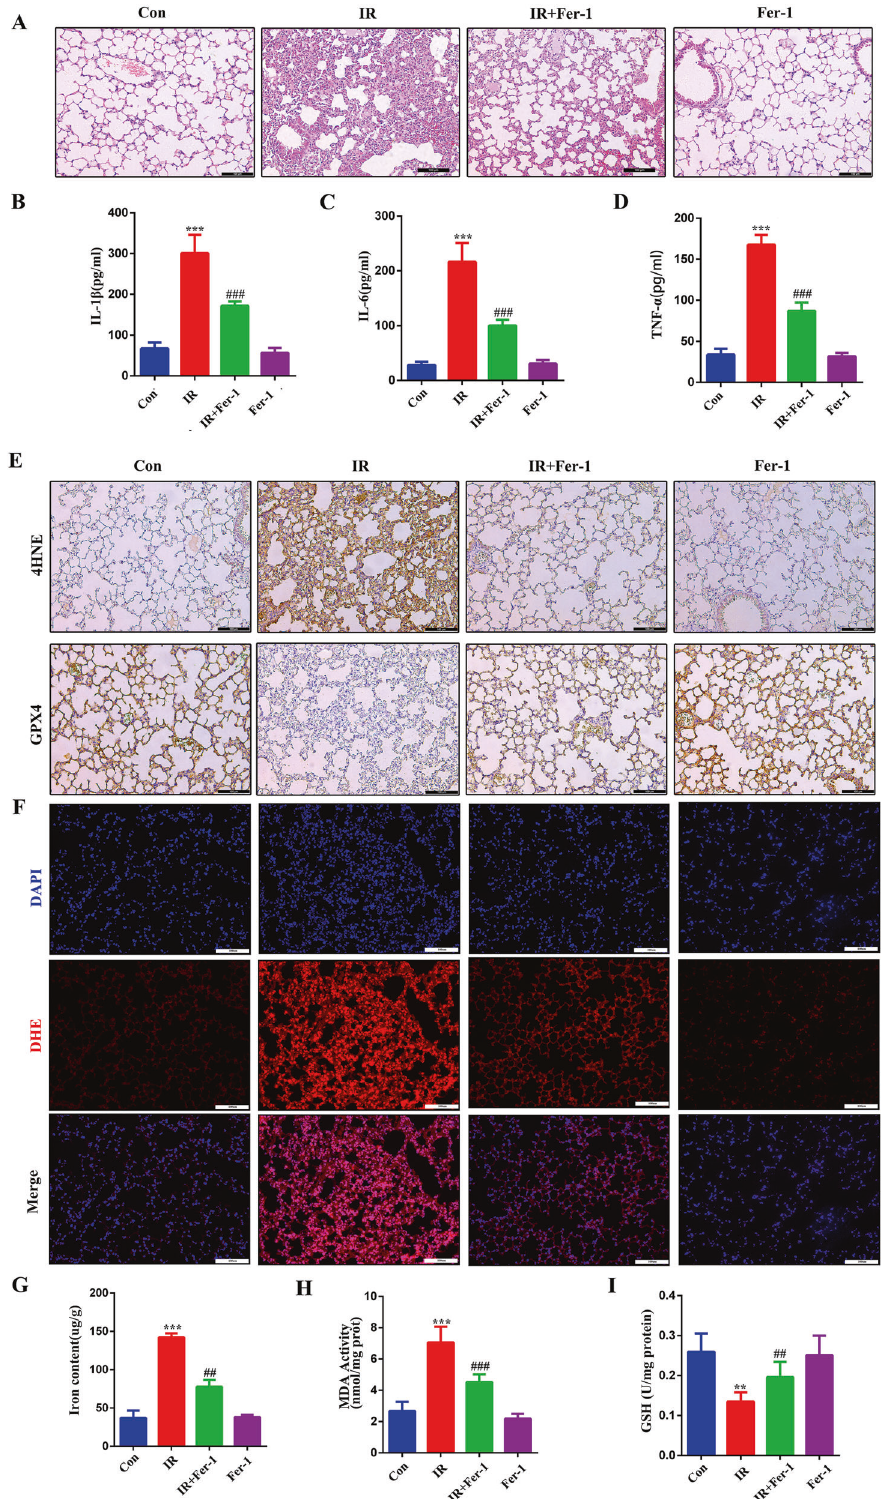
Fig. 3 Ferroptosis is involved in radiation-induced lung injury. The mice were treated with ferrostatin-1 (5 mg/kg) or DMSO. A H&E staining of lung. B – D Concentrations of IL-1 β ( B ), IL-6 ( C ), and TNF- α ( D ) in the Serum. E Representative IHC images of GPX4 and 4HNE in the lung sections. F Representative DHE fl uorescence images of the mouse lung tissues. G – I Activities of iron content, MDA, and GSH in the mouse lung tissues. #/ * P < 0.05, ##/ ** P < 0.01, ###/ *** P < 0.001, # vs. IR group; * vs. control group.